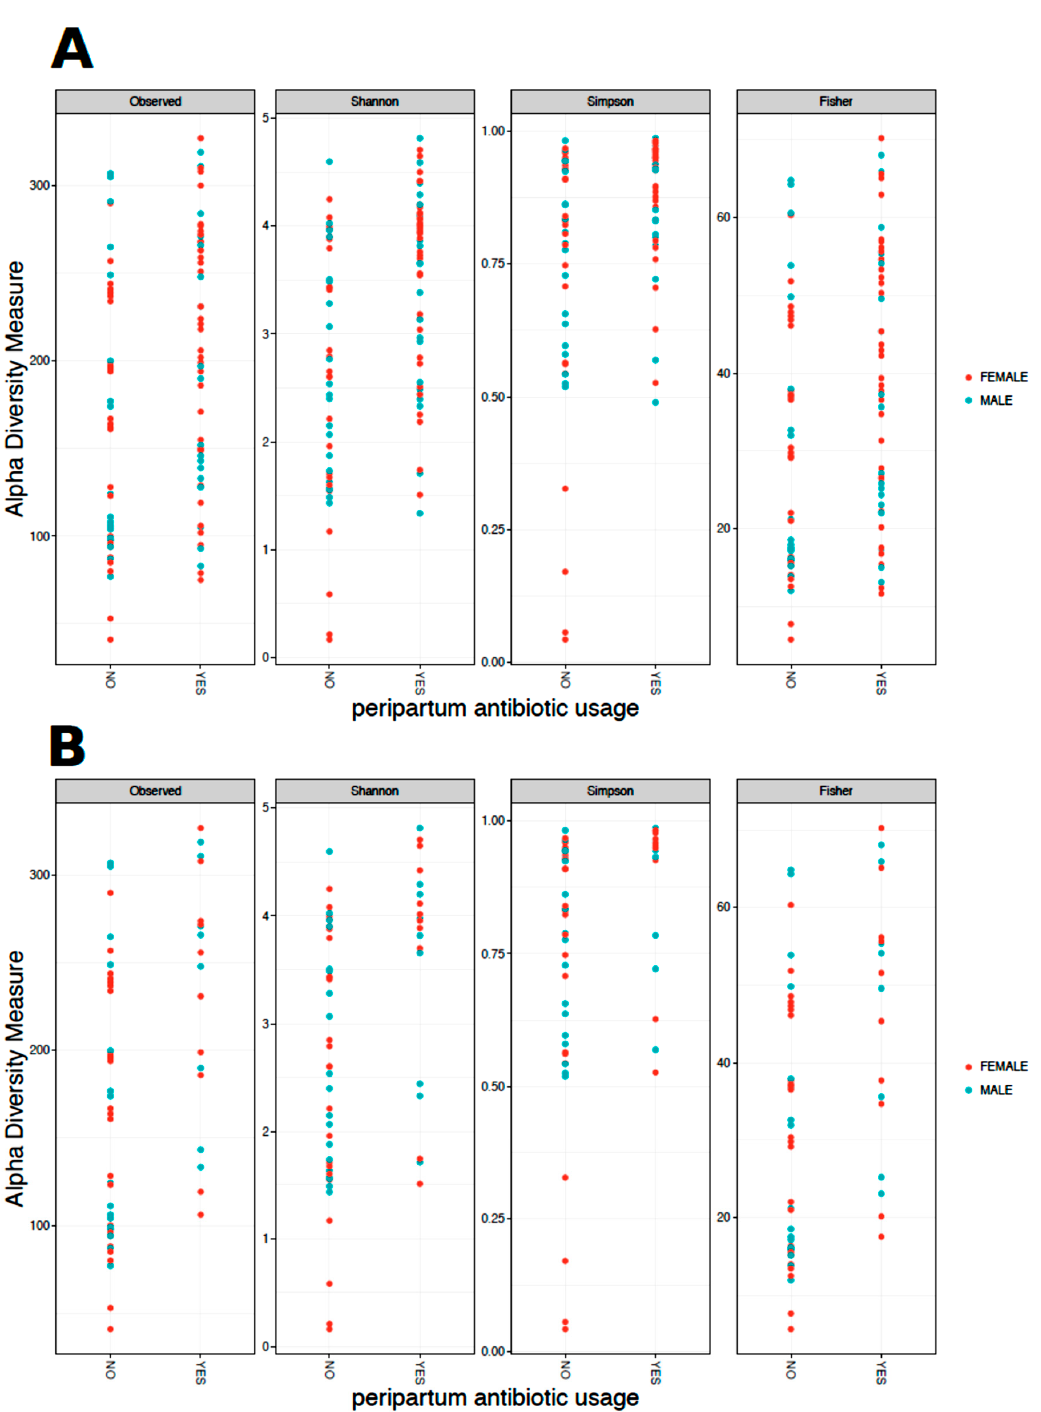
Figure 1. ( a ) Alpha diversity of 105 meconium samples stratified by peripartum antibiotic use (yes / no) and sex. Peripartum antibiotic use was associated with higher Shannon and Simpson diversity ( p < 0.05), but a lower number of OTUs and Fisher diversity ( p < 0.05). ( b ) Alpha diversity of meconium samples from infants born by vaginal delivery, stratified by peripartum antibiotic use (yes / no) and sex. Peripartum antibiotic use was associated with higher alpha diversity according to all four measures (p < 0.05, two sample Wilcoxon test).